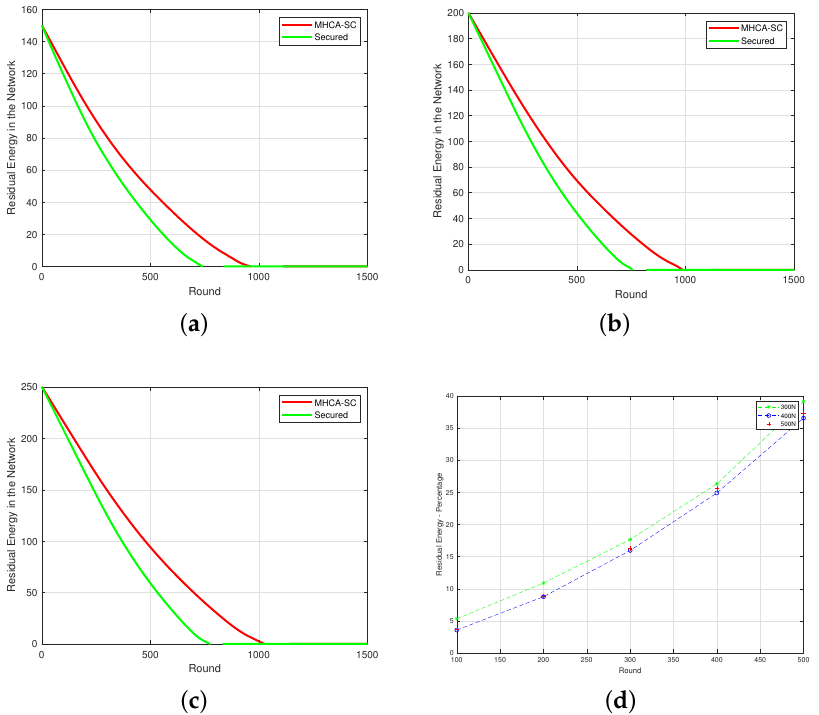
Figure 6. Mean residual energy. ( a ) 300-node model. ( b ) 400-node model. ( c ) 500-node model. ( d ) Residual energy percentage.